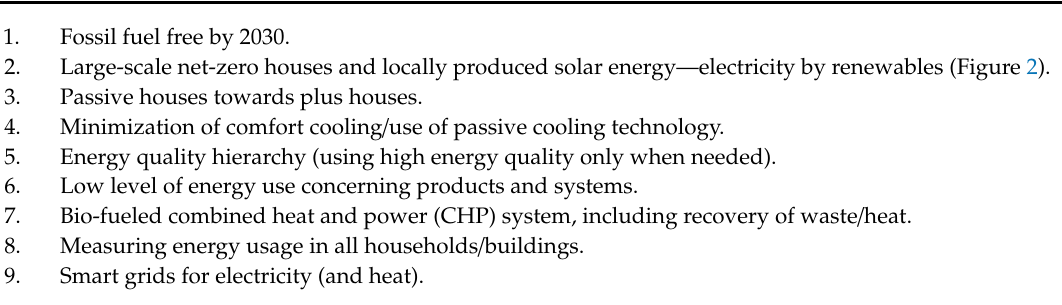
Table 2. Energy goals of